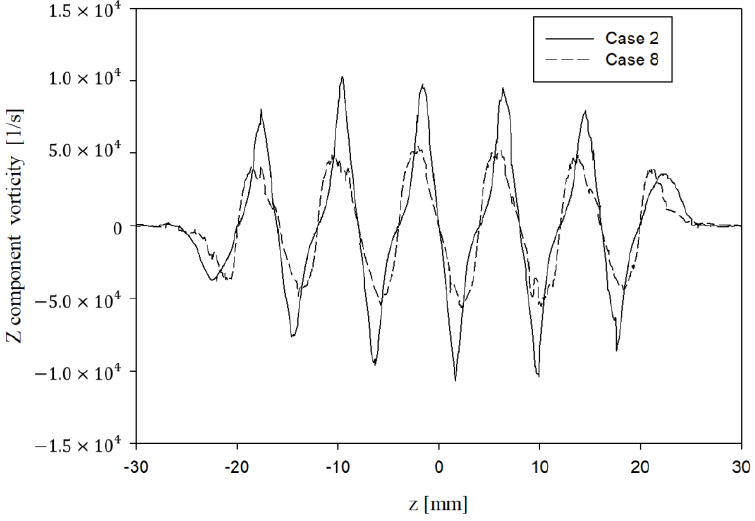
Figure 18. Comparison of 𝒛 -component vorticity in Case 2 and Case 8.